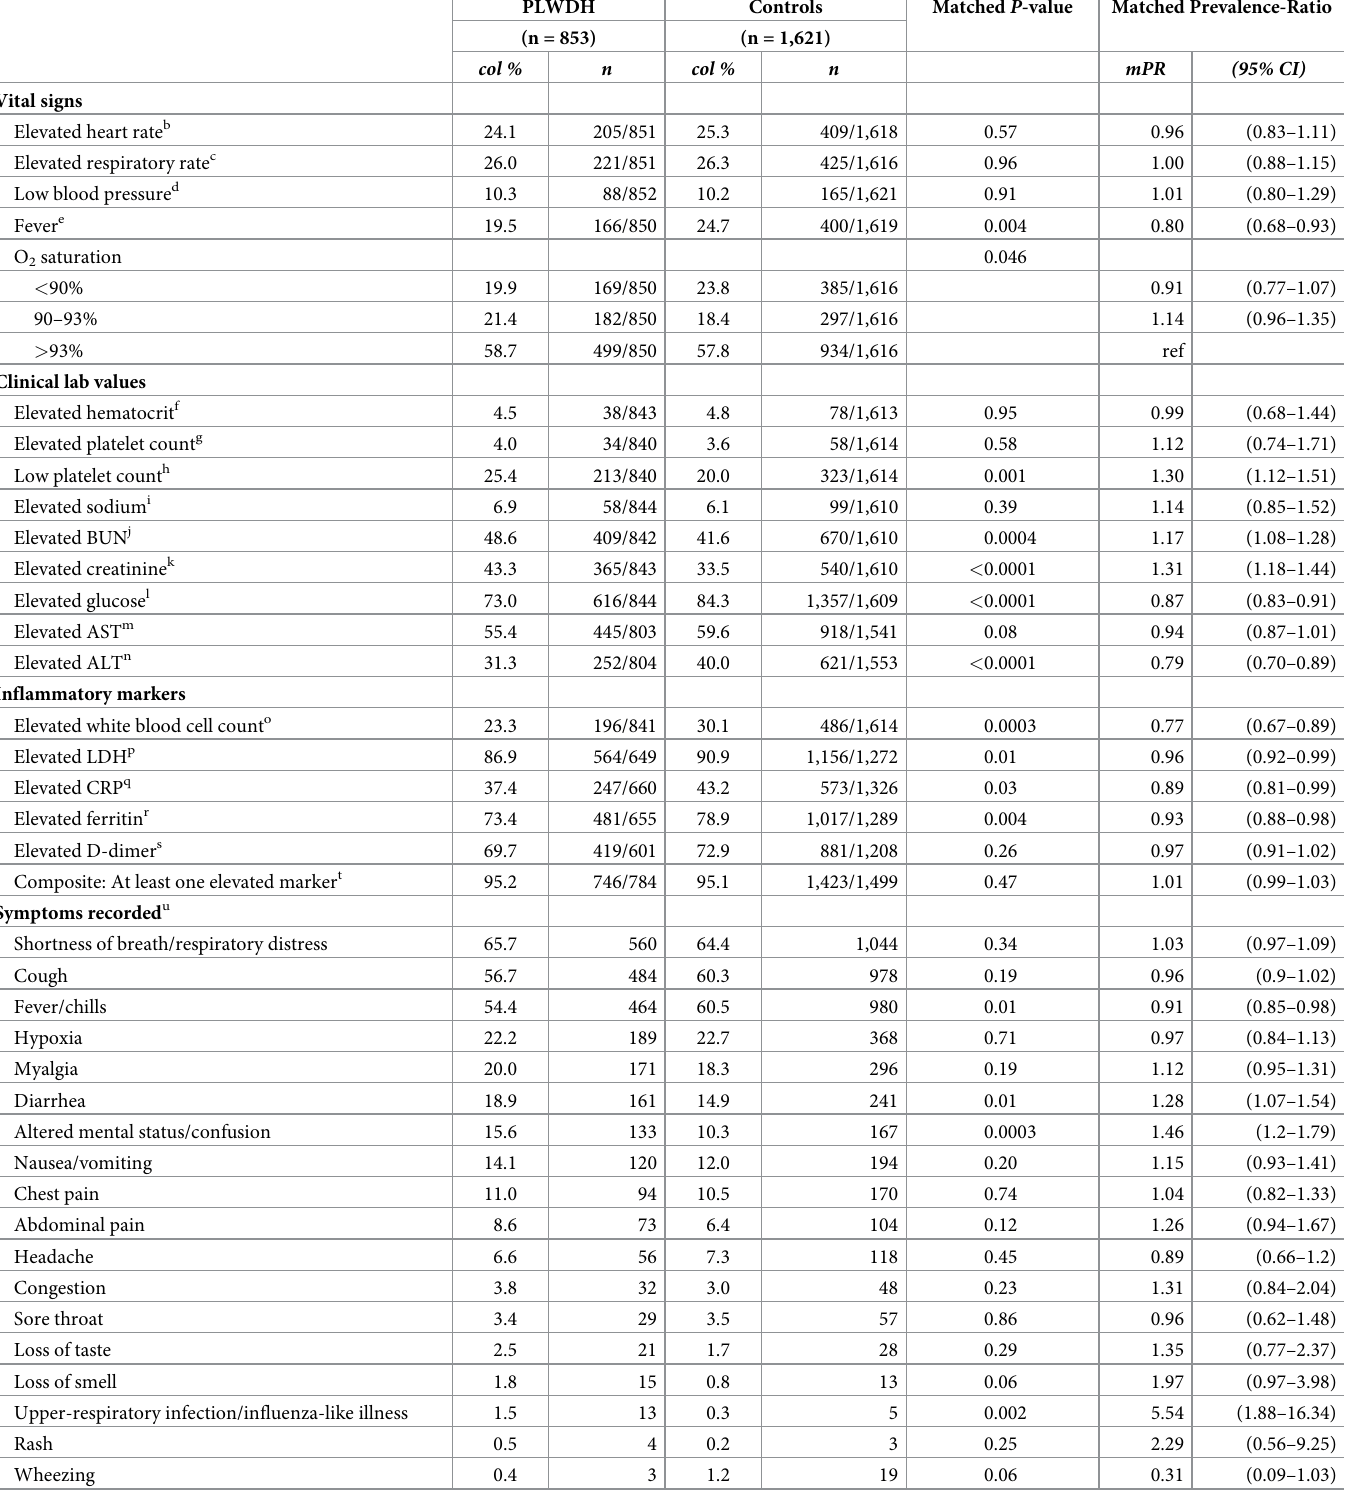
Table 3. Vital signs, lab values, and symptoms at admission among PLWDH and matched controls a